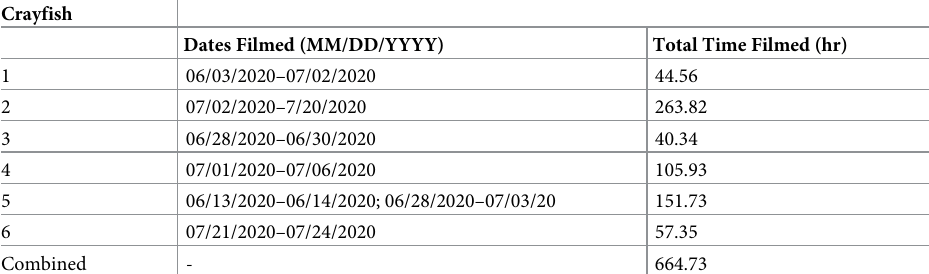
Table 1. Dates and total time that each crayfish was filmed throughout the duration of our study. Only a single crayfish (Crayfish 5) was filmed discontinuously due to failure of the video recorder. Crayfish Dates Filmed (MM/DD/YYYY)